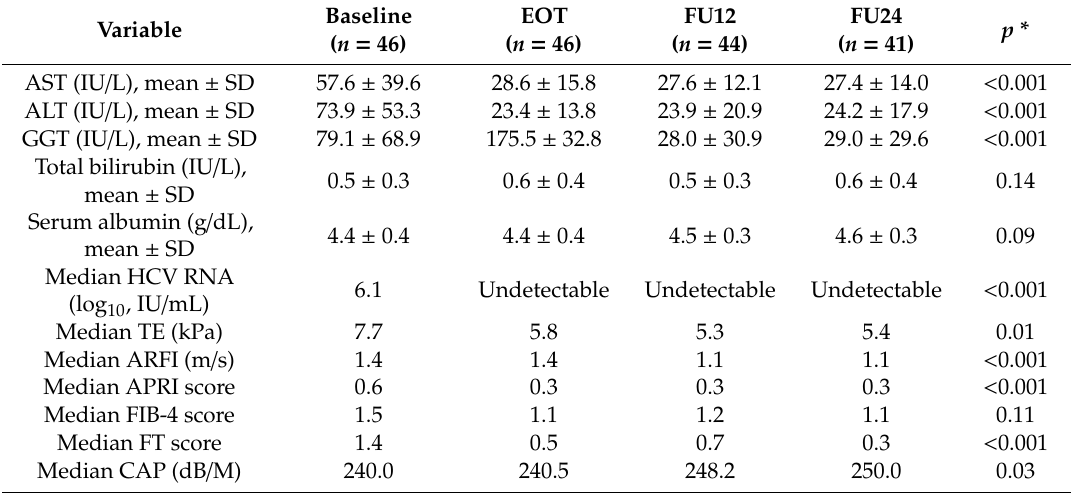
Table 2. Liver parameters, HCV RNA, and liver sti ff ness during follow-up.